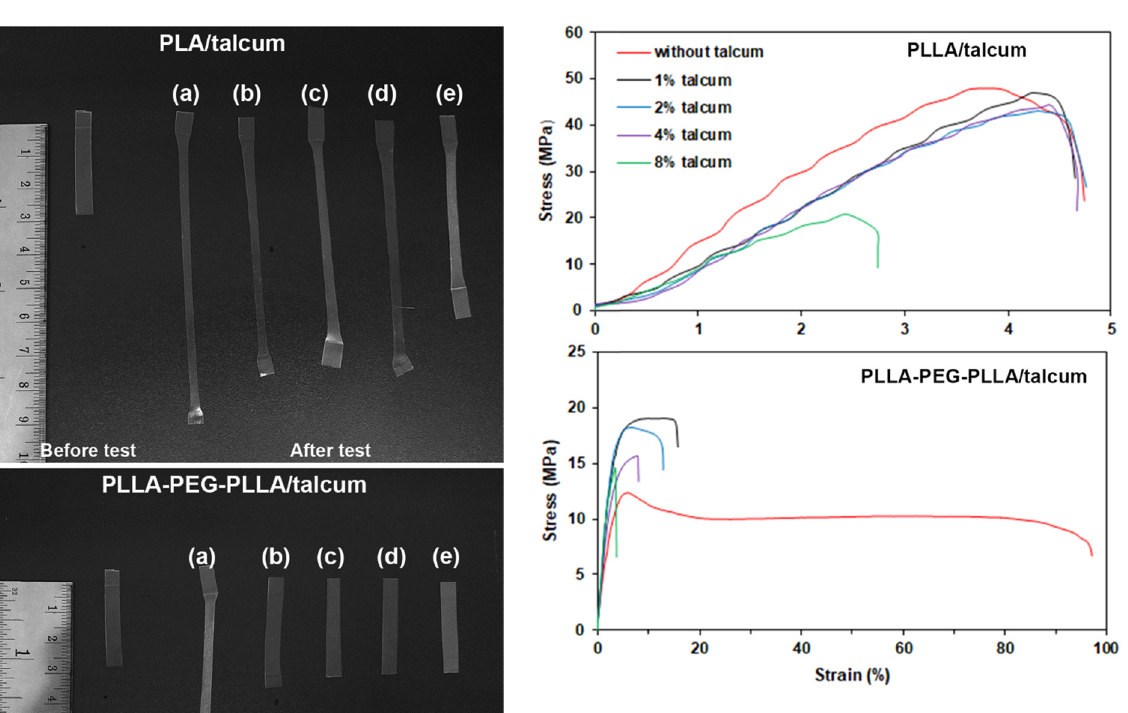
Figure 8: Tensile curves of ( above ) PLLA/talcum and ( below ) PLLA - PEG - PLLA/talcum composite fi lms for various talcum